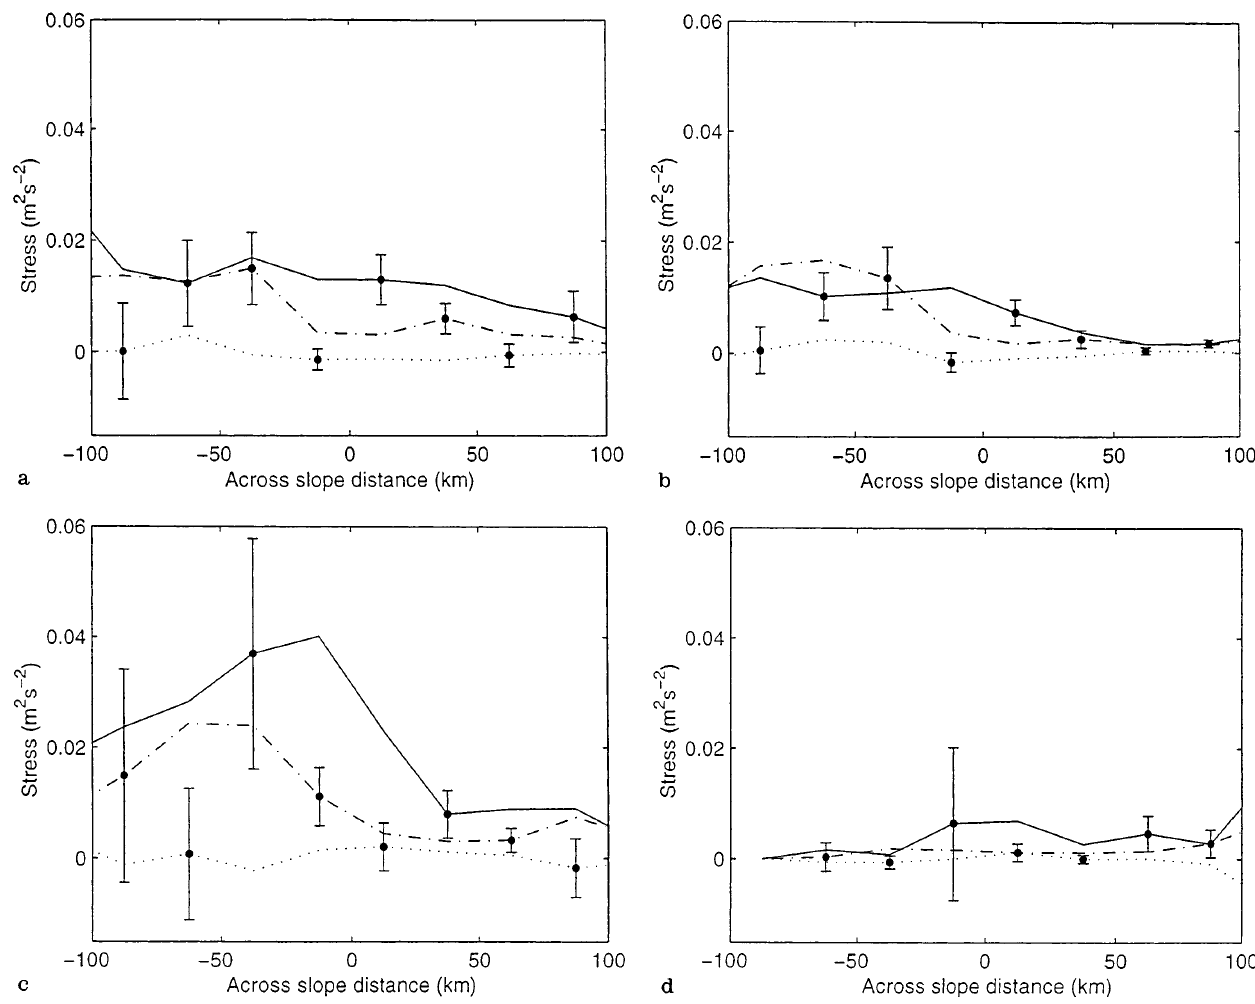
Fig 10a–d. h u 0 u 0 i ( dot-dashed ), h v 0 v 0 i ( solid ) and h u 0 v 0 i ( dotted ) calculated as spatially and temporally averaged deviations from the mean current. Profiles across the a Hebrides slope during winter,